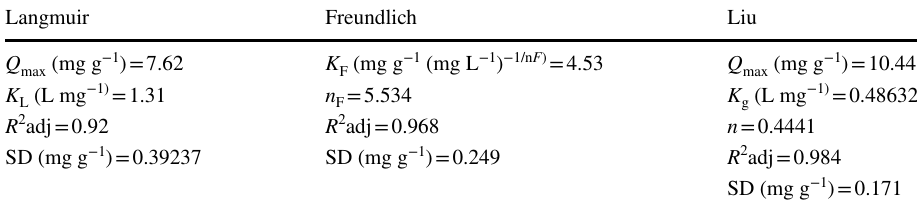
Fig. 12 The recyclability of the L-Asp capped Fe (1 mg mL −1 ) for the removal of RhB (5 mg L −1 ) within 5 successive runs. (Error bar represents 5%